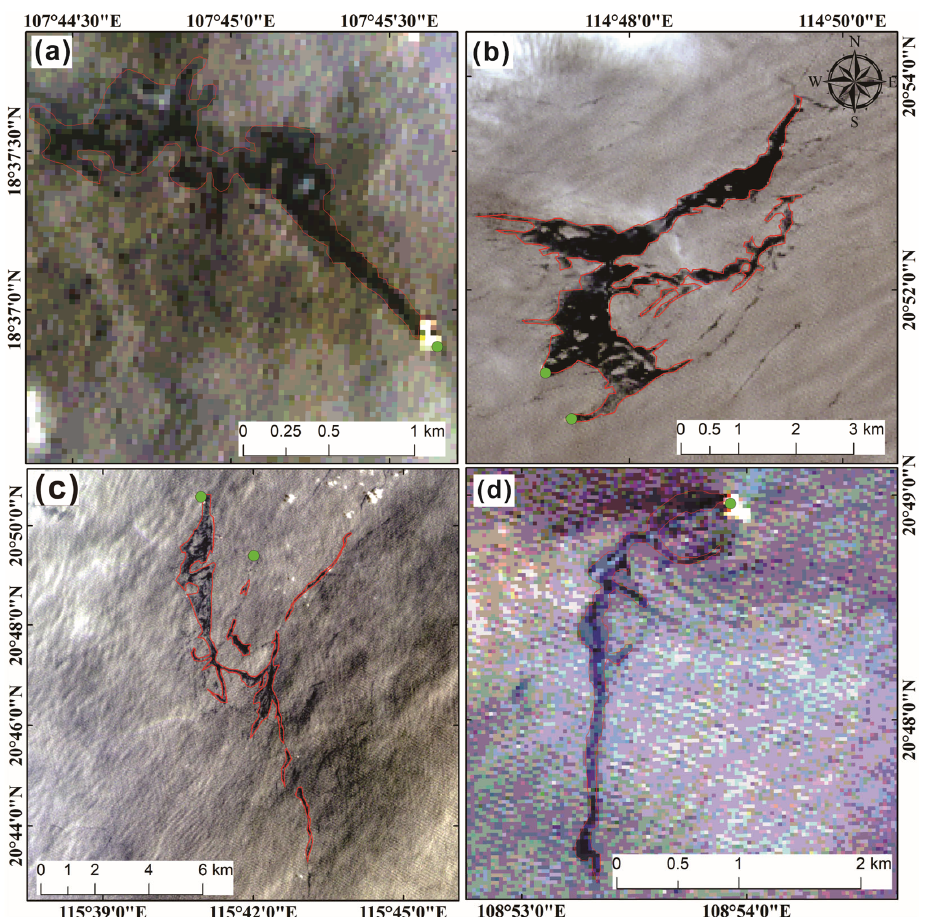
Figure 9. RGB imagery of oil slicks determined from platform sources in cases ( a – d ). The green dots denote oil platform locations.